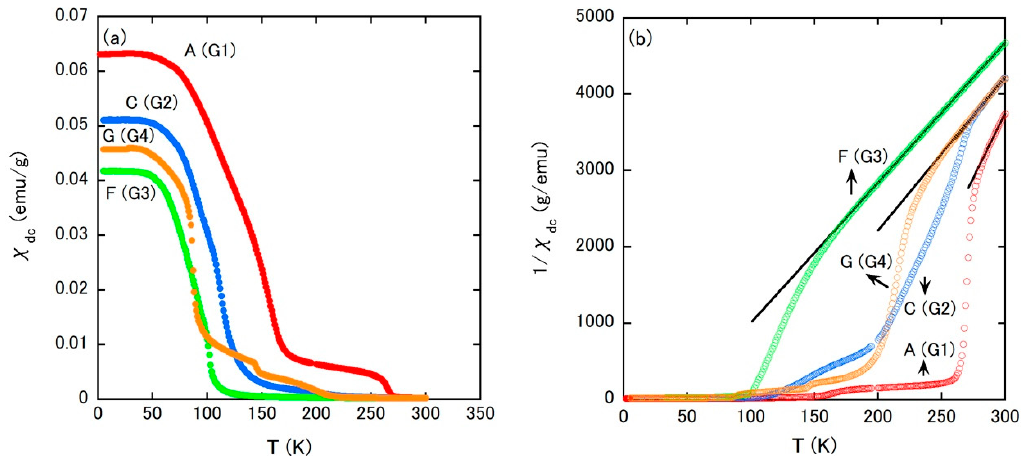
Figure 7. ( a ) Temperature dependences of χ dc for samples A, C, F, and G. The external field is 10 Oe. ( b ) Temperature dependences of 1 / χ dc for samples A, C, F, and G.